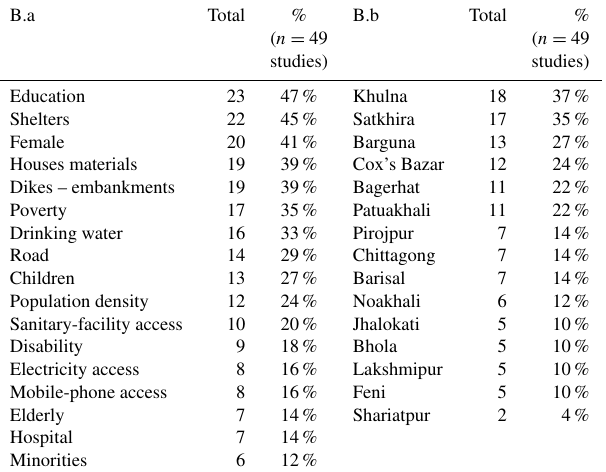
Table B1. Citation frequency in the literature review of the selected variables (B.a) and coastal districts